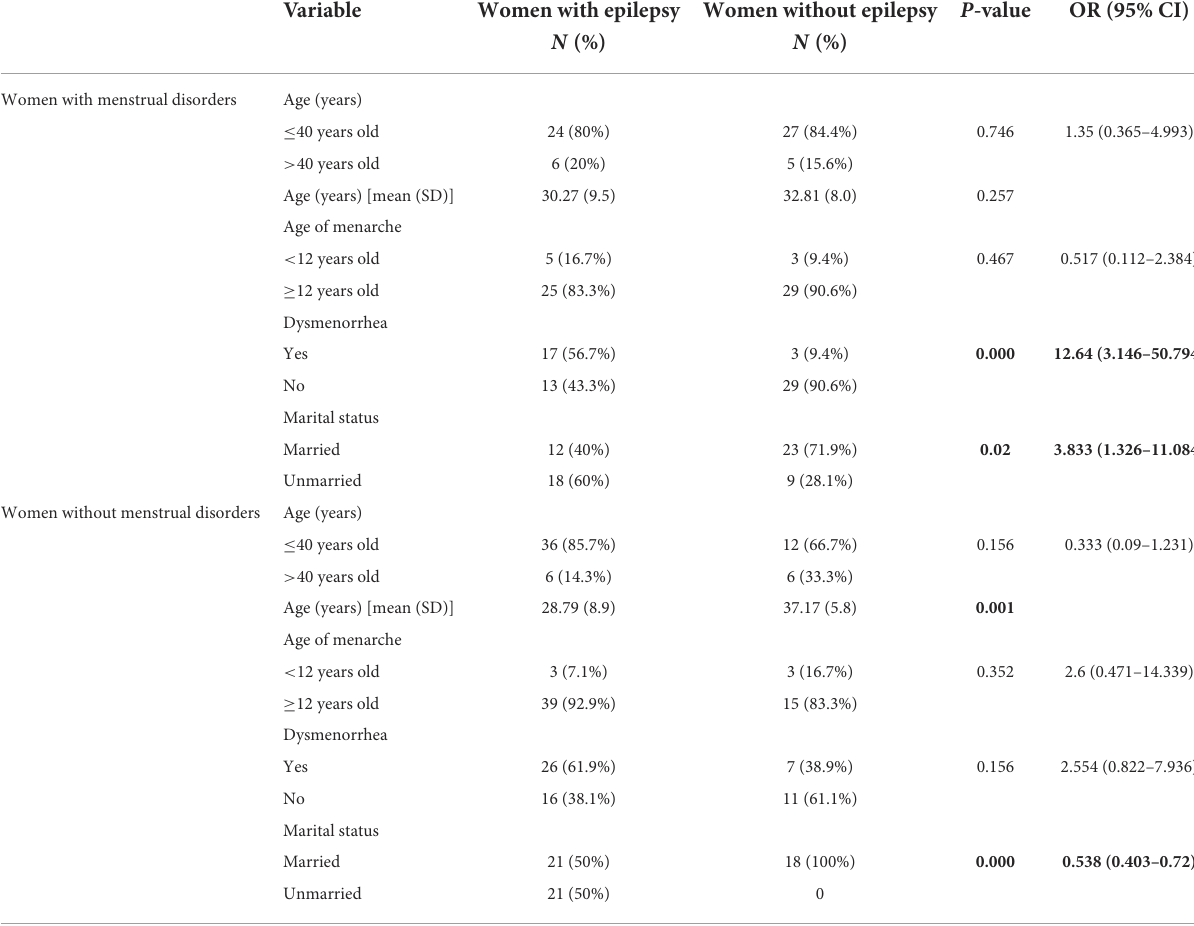
TABLE 2 Comparison of demographic and hormone characteristics between women with menstrual disorders and women without menstrual